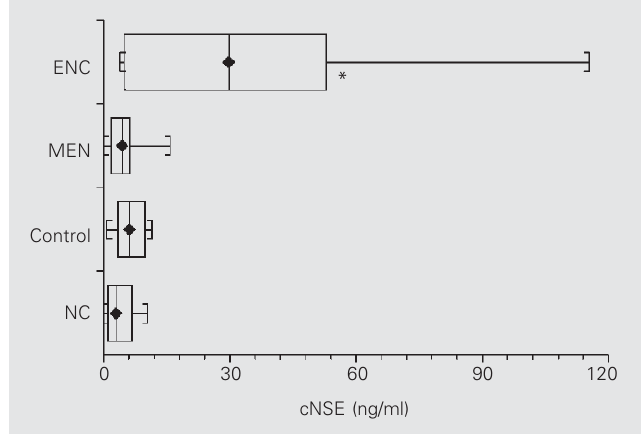
Figure 1. Distribution of neuron-specific enolase levels in cerebrospinal fluid (cNSE) in patients with encephalic disease (ENC; N =7), meningitis (MEN; N = 11) and neurocysticercosis (NC; N = 25). Control (N = 8). *P = 0.01 compared to the other groups (Kruskal-Wallis